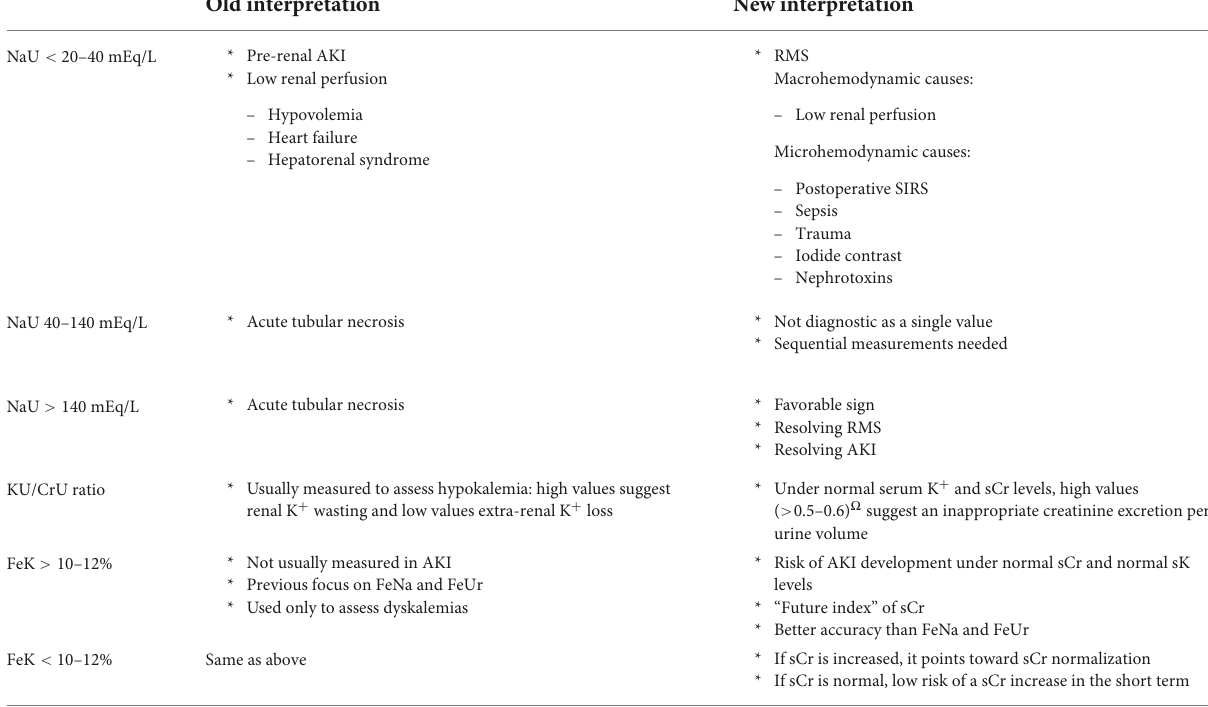
TABLE 1 Old and new interpretation of urine electrolytes and urinary indices in patients with acute kidney injury